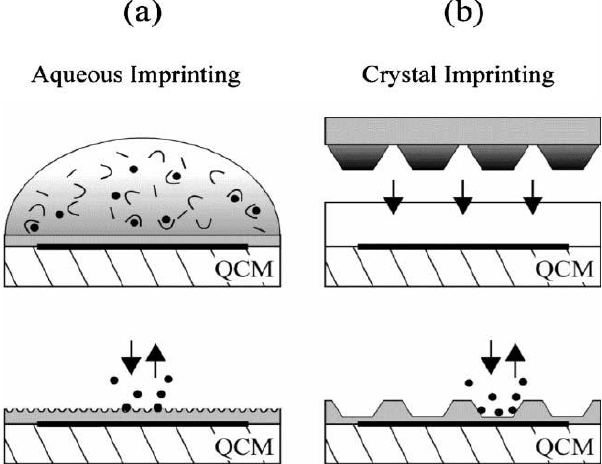
Figure 1. Surface-imprinting strategies on pre-coated QCMs. ( a ) Aqueous monomer solution containing the template is dripped onto the transducer surface for self-organizing receptor sites on the thin film surface. ( b ) A stamp with densely packed trypsin crystals is pressed into the pre-polymerized coating, templates are removed after polymerization. Reprinted with permission from [10], © 2006 The Royal Society of